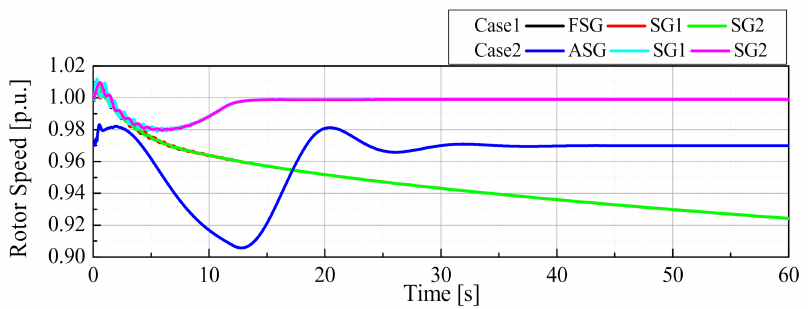
Figure 16. Generator rotor speed (Generating Operation).